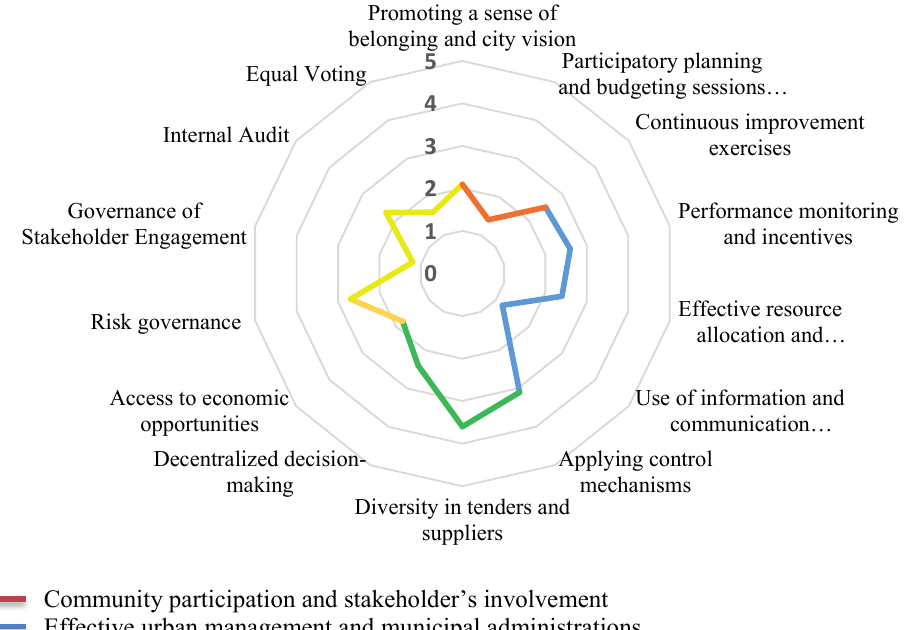
Fig. 12. Measuring the performance of the urban projects through the sub- indicators (created by the